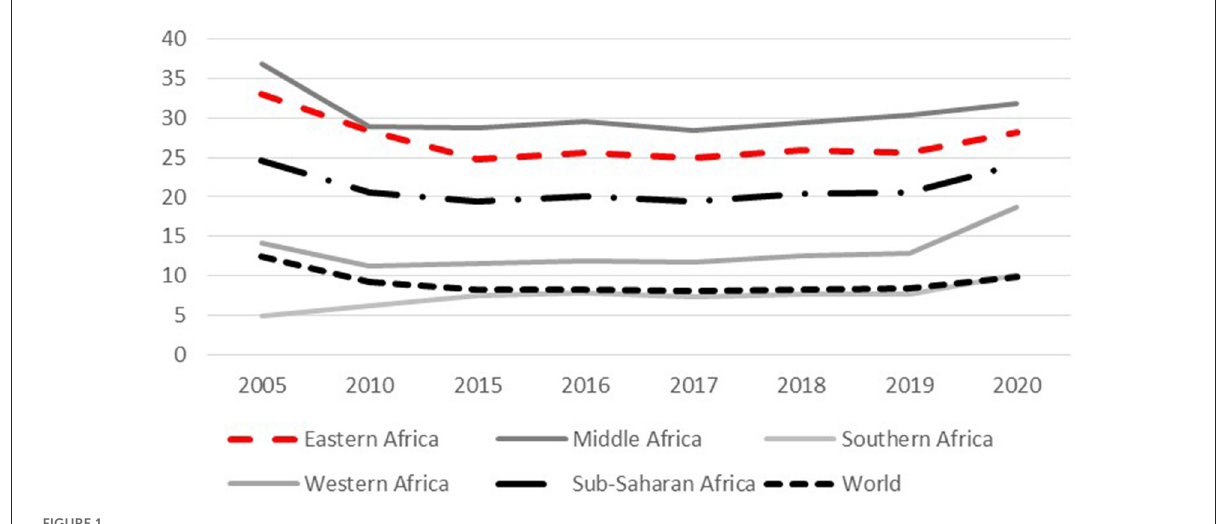
FIGURE1 Prevalence of undernourishment in % of population